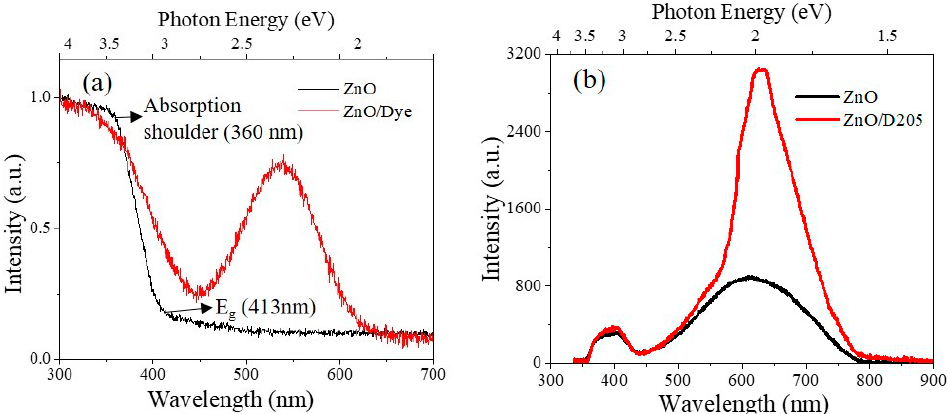
Figure 2. ( a ) Absorption and ( b ) photoluminescence (PL) spectra of the zinc dross originated ZnO nanoparticle films with (red-colored) and without (black-colored) dye adsorption. To investigate the interfacial electron transfer between D205 dye and ZnO nanopar- ticles originated from Zn dross, the time-resolved PL decay measurements were taken at 400 nm and 600 nm. Figure 3 shows time-resolved PL decay curves at 400 nm and 600 nm emission wavelength recorded for ZnO nanoparticles with and without dye